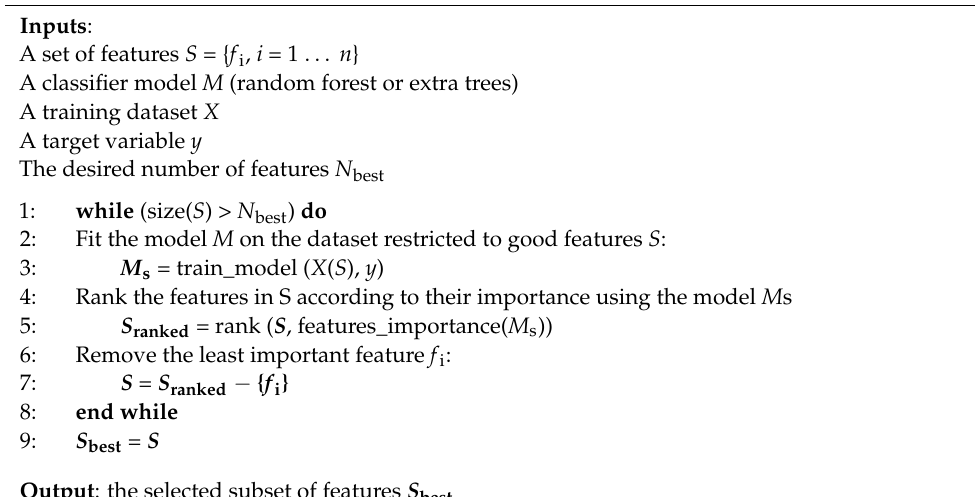
Algorithm 1 Recursive Feature Elimination